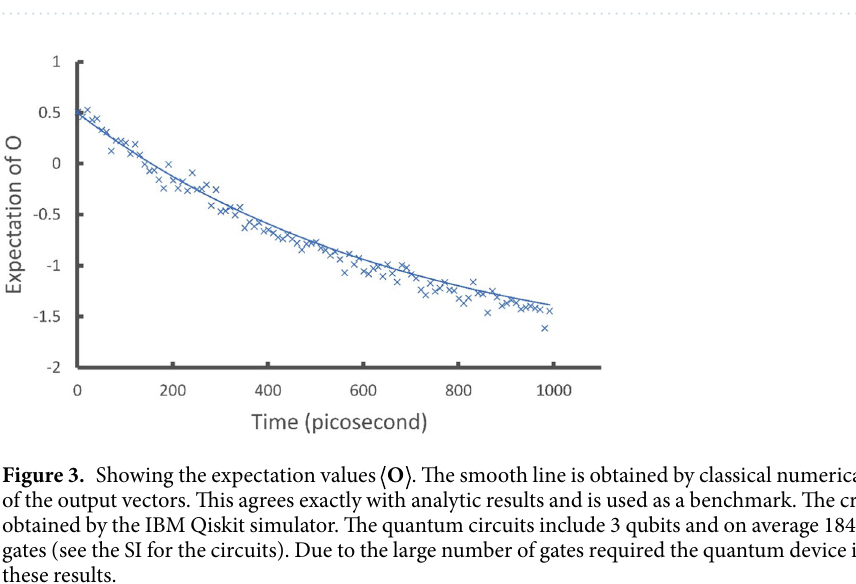
Figure 2. Showing the populations of the + and − states for the amplitude damping model. The smooth lines are obtained by classical numerical calculations of the output vectors. These agree exactly with analytic results and are used as benchmarks. The crosses are obtained by the IBM Qiskit simulator. The dots are obtained by the IBM Q 5 Tenerife device. The quantum circuits include 2 qubits and on average 30 elementary gates (see the SI for the